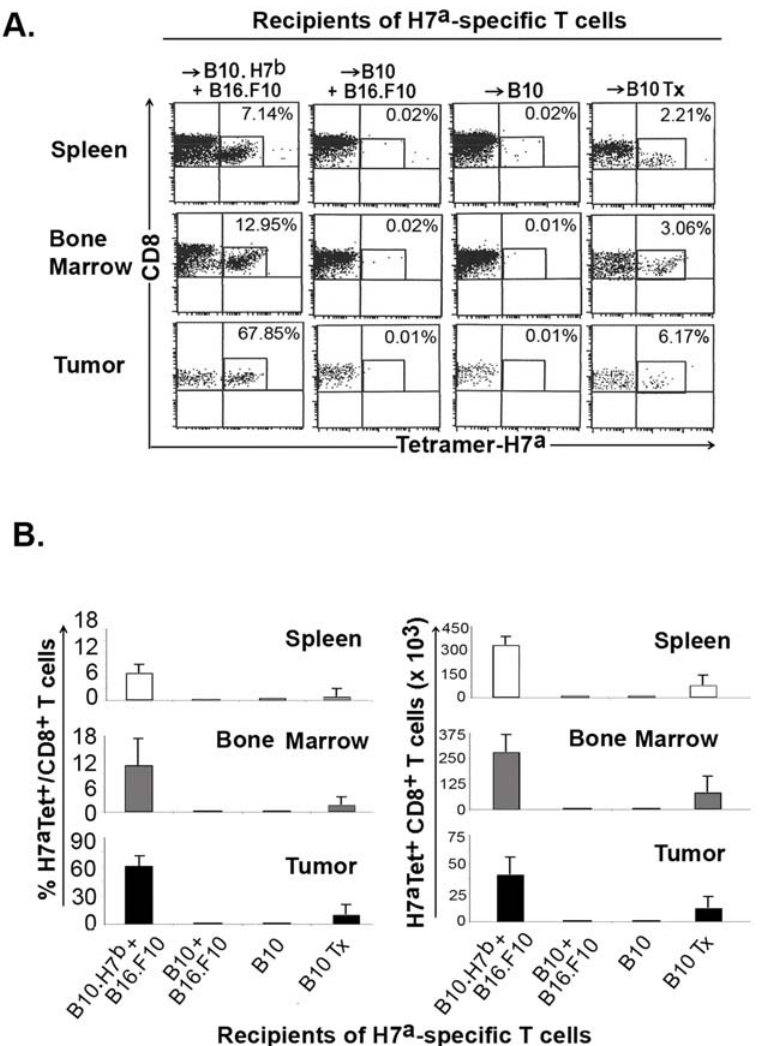
Figure 6. Anti-H7 a T-cell response following tumor challenge. We studied mice from the four experimental groups described in Fig. 4. On day 100, we challenged mice with 2 6 10 5 B16.F10 melanoma cells s.c. Mice were sacrificed on day 126 and cell suspensions from their spleen, bone marrow and tumor were stained with H7 a tetramers and anti-CD8 antibody. A) Dot plots of one representative experiment out of three (gated on CD8 cells). B) Proportion and absolute number of H7 a -specific T cells in recipients’ spleen, bone marrow (2 tibiae and femurs) and tumor on day 126. Results are depicted as the mean 6 SD of 3 mice per group. Absolute numbers of H7 a -specific T cells in the three sites were higher in thymectomized relative to euthymic B10 hosts (0.02 , P , 0.002), and were higher in B10.H7 b than in euthymic ( P , 0.0005) or thymectomized ( P , 0.01) B10 hosts. Tx, thymectomized.